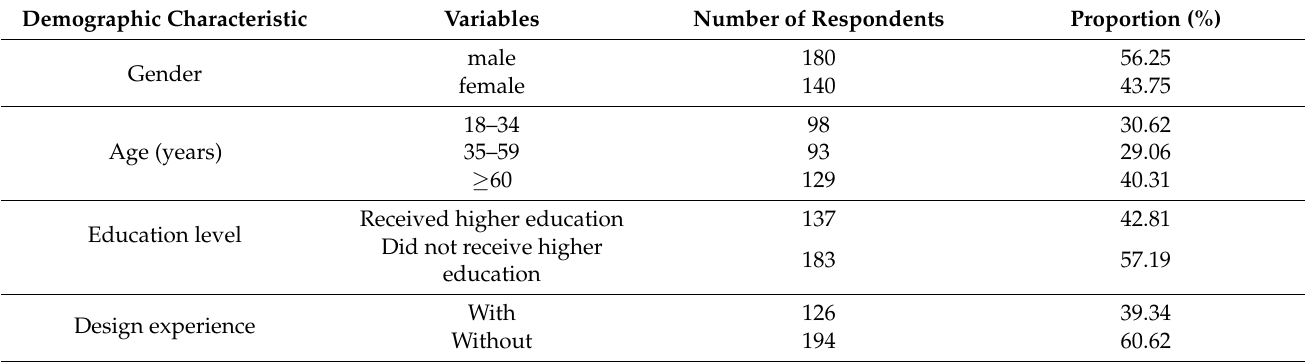
Table 5. Statistics of demographic characteristics of survey respondents.